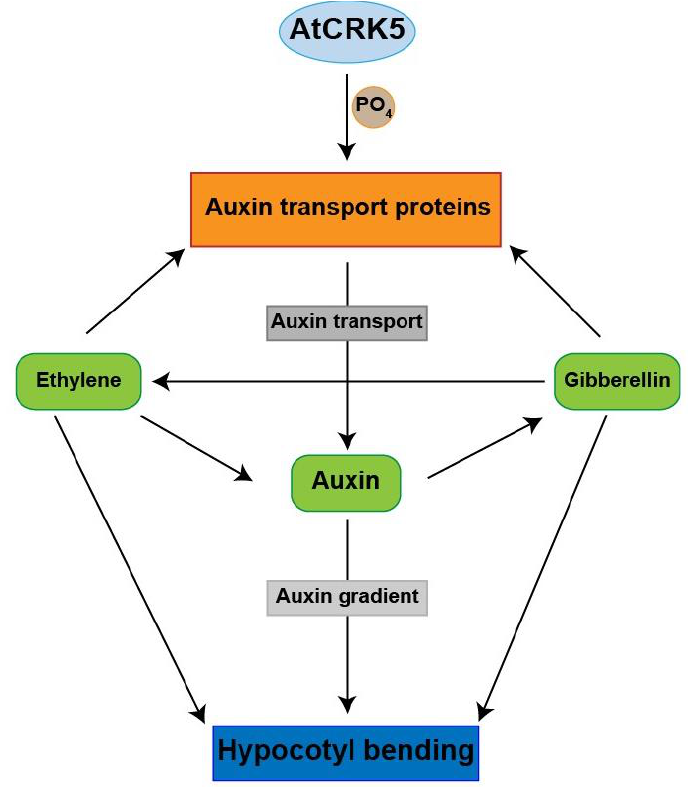
Figure 8. Hypothetical role of the AtCRK5 protein kinase in the regulation of hypocotyl bending during skotomorphogenesis in Arabidopsis thaliana . AtCRK5 is proposed to a ff ect the auxin homeostasis increasing the stability of auxin transporter proteins and thus contributing to auxin transport e ffi ciency and gradient establishment. The increased auxin level at the inner side of the hook is in a feedback loop with ethylene and gibberellin synthesis / signaling and their coordinated and balanced function is required for hypocotyl bending. Absence of the kinase hinders the establishment of the proper auxin gradient due to lowered auxin transporter stability. The lower level of auxin and / or its altered distribution feeds back to ethylene and GA signaling / synthesis and a new hormonal balance is established at a shallow auxin gradient resulting in limited hypocotyl closure but proper timing of its development.